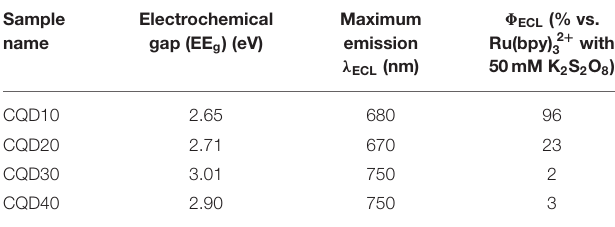
TABLE 2 | Electrochemical information from differential pulse voltammetry of all CQDs in solution and electrochemiluminescence testing of CQD films in the presence of potassium